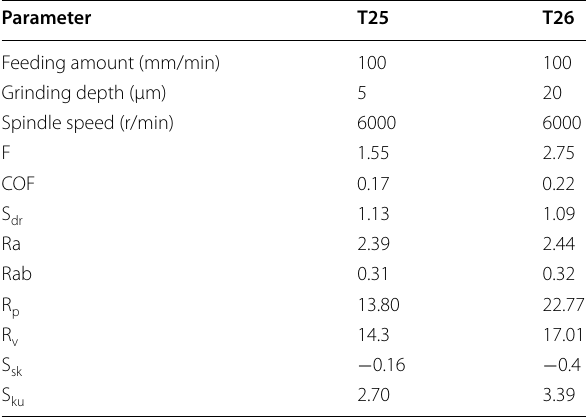
Table 6 Experimental parameters comparison of